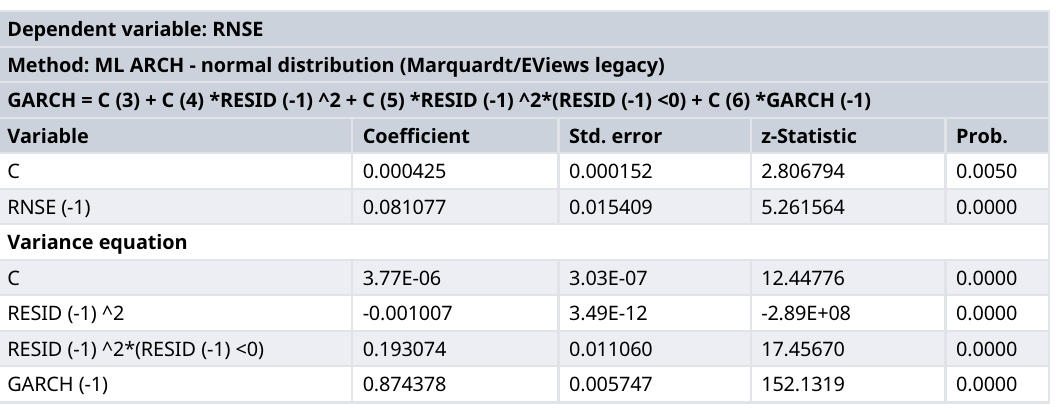
Table 5. The results of TGARCH. Dependent variable: RNSE